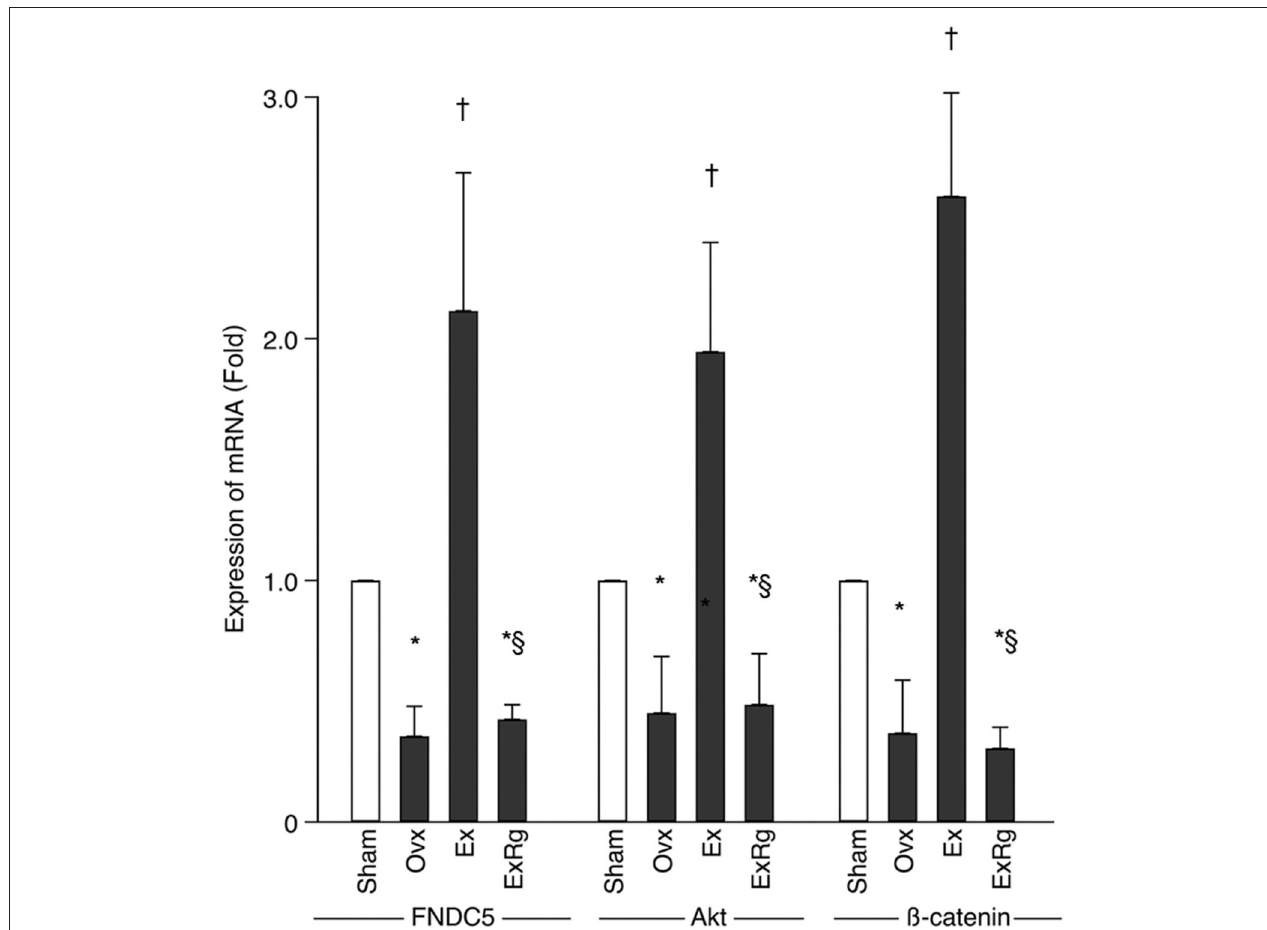
FIGURE 4 | The mRNA levels of FNDC5, Akt, and β -catenin. PCR analysis was performed for sham, ovariectomized (Ovx), Ovx plus exercise (Ex), and Ovx plus exercise and cRGDyk (ExRg) groups (each group, n = 10). Data are presented as mean ± SD. FNDC5, fibronectin type III domain-containing protein 5. *Denotes the difference between Sham group and Ovx, Ex, and ExRg groups was significant ( p < 0.05); † indicates the difference between Ovx group and Ex and ExRg groups was significant ( p < 0.05); § presents the difference between Ex group and ExRg group was significant ( p <